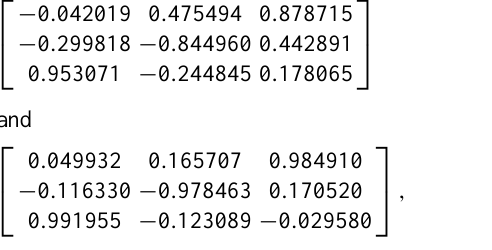
is 200 km/s or 250 km/s in the LLBL, the V l negative